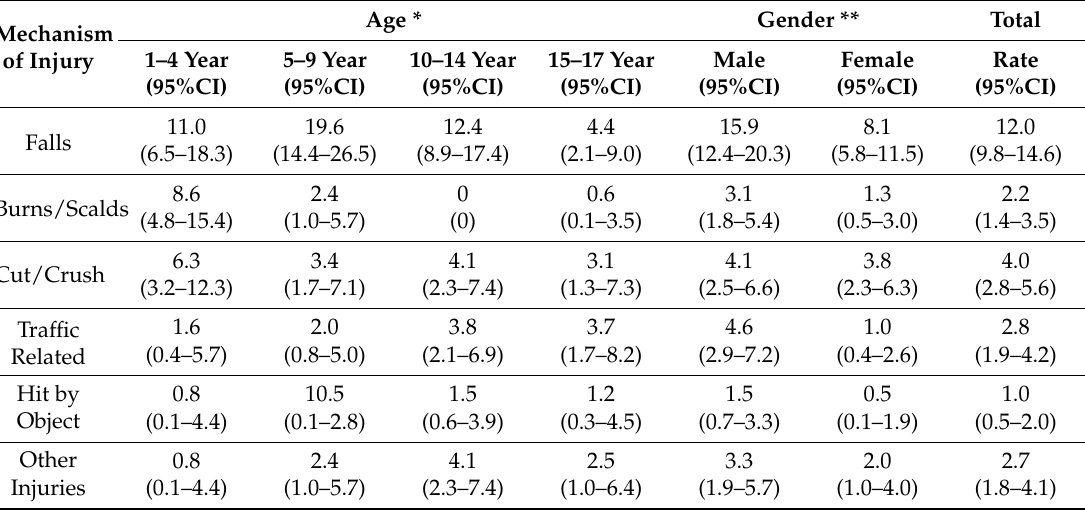
Table 3. Rates (per 1000) of non-fatal injuries by age groups, gender and